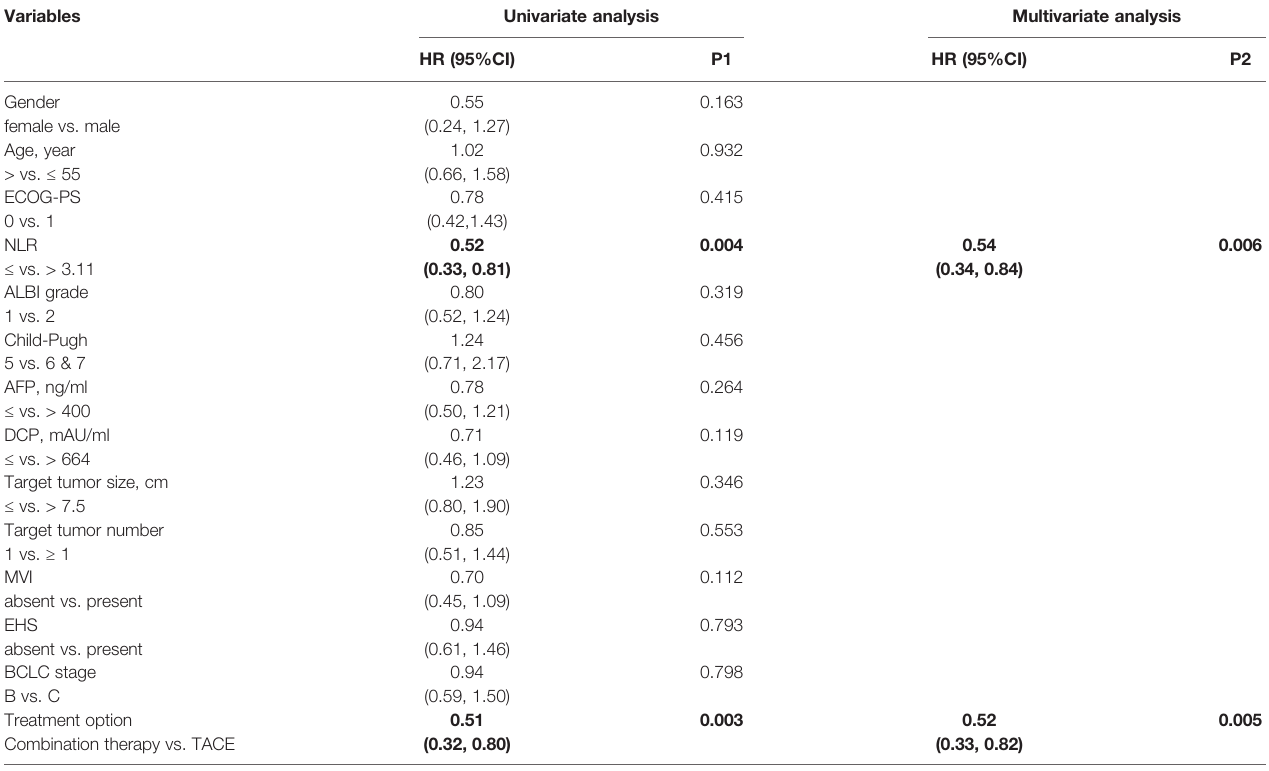
TABLE 3 | | Univariate and multivariate analyses factors associated with progression-free survival.